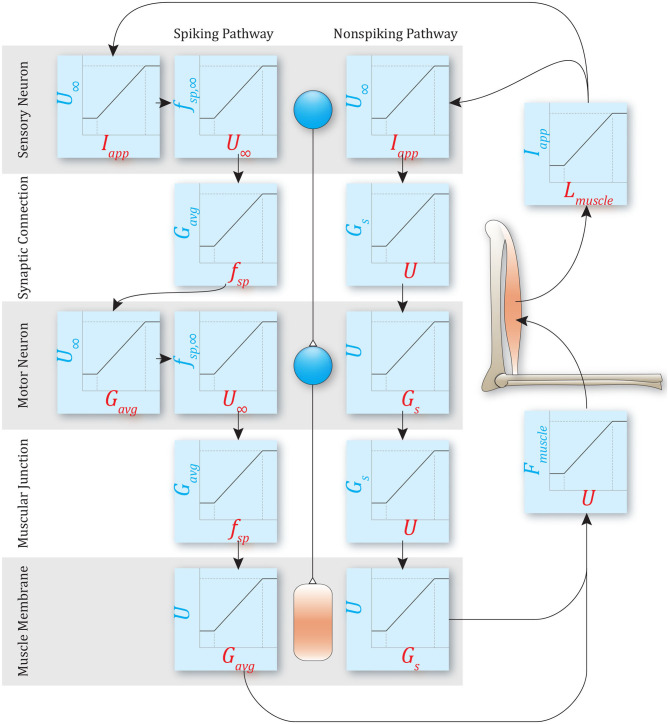
An example of a simple reflex pathway that encodes muscle stretch and decodes to muscle force. Both non-spiking and spiking implementations are shown. Both methods require mapping to and from mechanical states and neural states, but the specific transforms required depend on the model used. The rest of this manuscript demonstrates the relationships between parameters in these models.